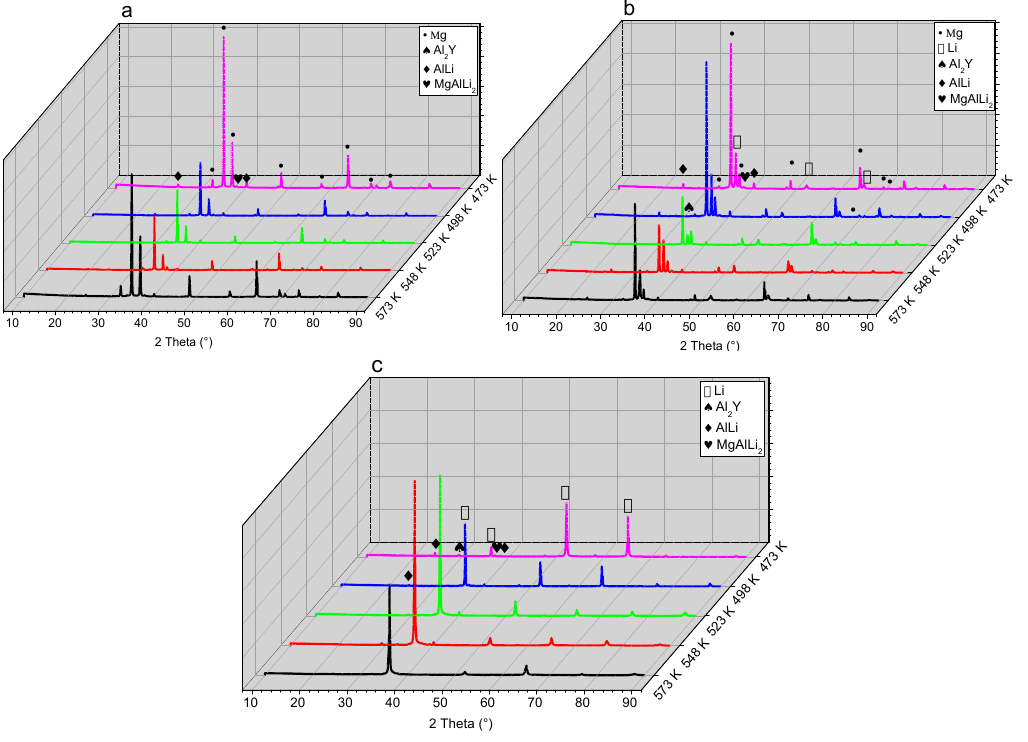
Figure 6. XRD patterns of as-rolled alloys annealed at different temperatures for 24 h: XRD patterns of as-rolled alloys annealed at different temperatures for 24 h: ( a ) Mg-5Li-3Al-2Zn-0.2Y; ( b ) Mg-8Li-3Al-2Zn-0.2Y; ( c ) Mg-11Li-3Al-2Zn-0.2Y. ( a ) Mg-5Li-3Al-2Zn-0.2Y; ( b ) Mg-8Li-3Al-2Zn-0.2Y; ( c )